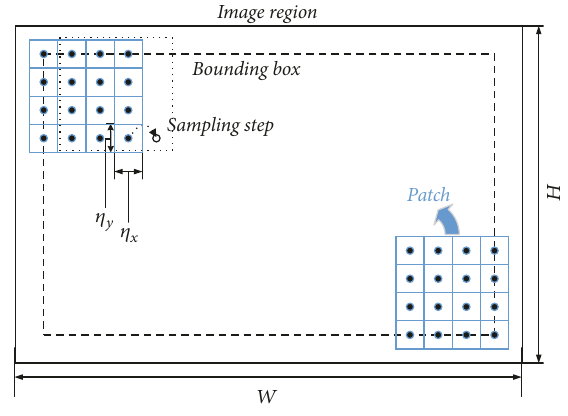
Figure 4: Dense-SIFT descriptor